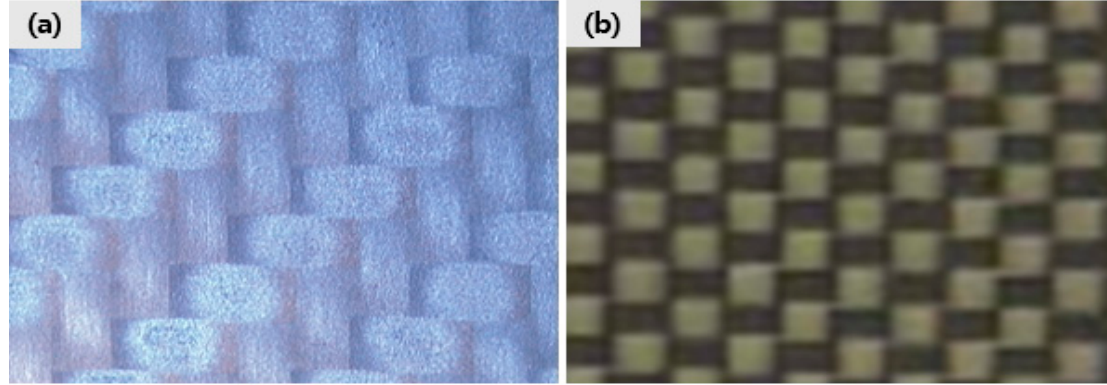
Figure 1. Images of ( a ) CFRP and ( b ) C-AFRP.